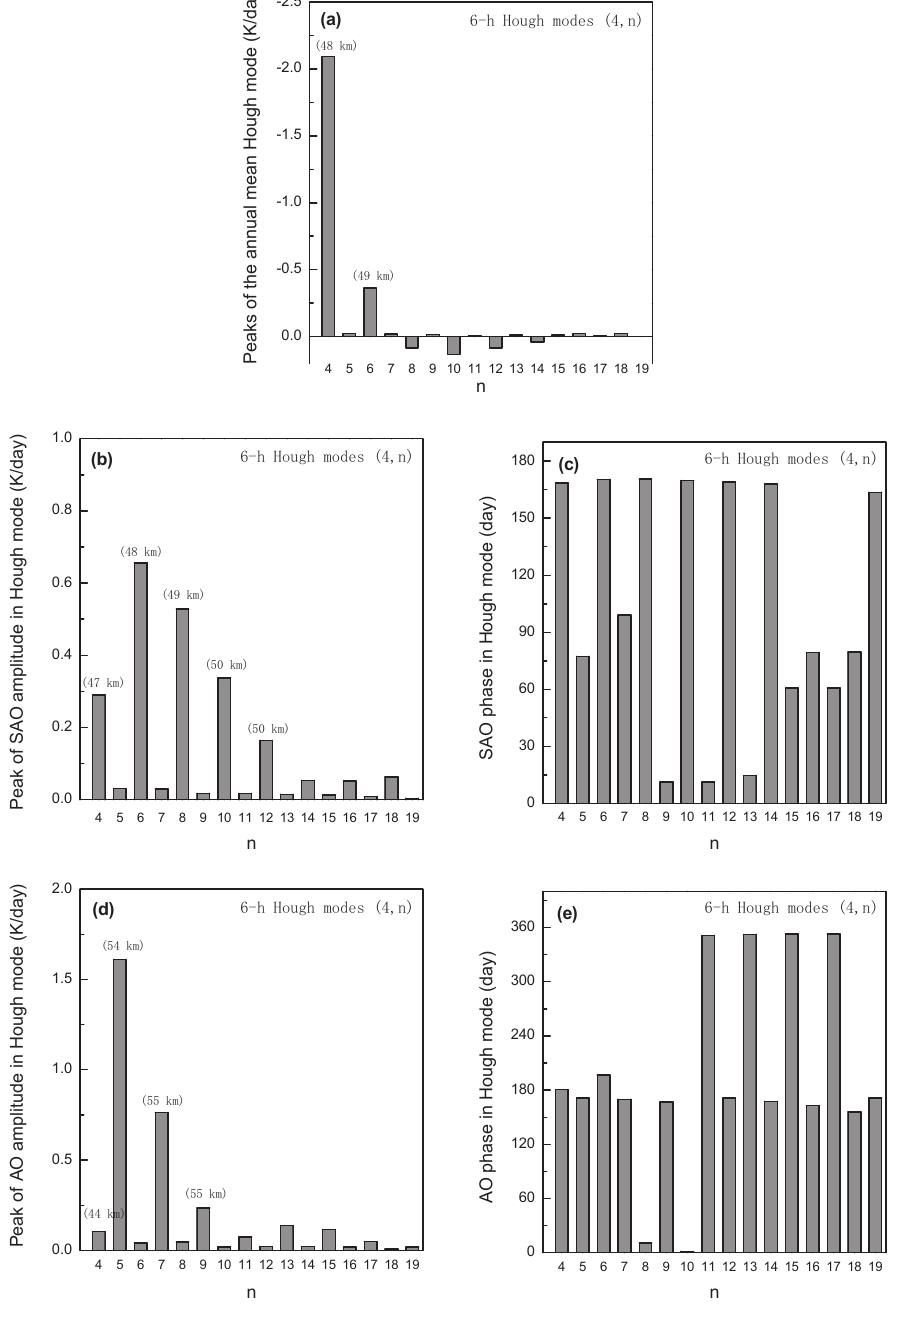
Fig. 18. The same as Fig. 12, but for 6-h Hough modes.